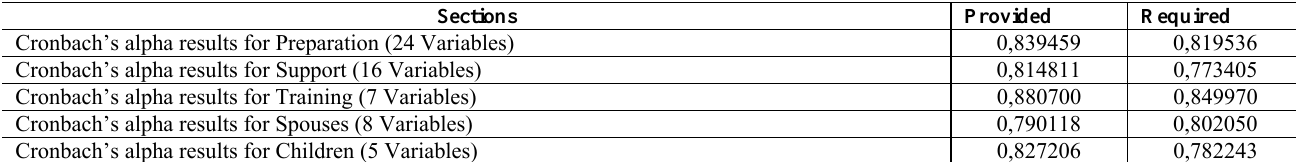
Table 1: Cronbach’s alpha values